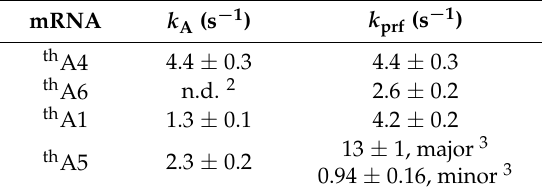
Table 3. Apparent rate constants for POST complex formation from PRE complexes 1